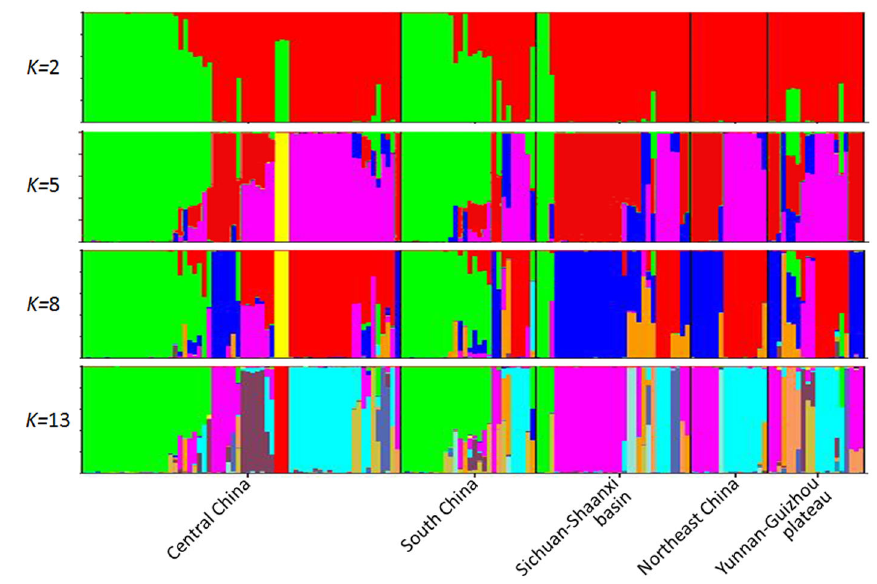
Figure 5. Population structure of U. virens inferred from 125 SNPs of 162 isolates using the program Structure (version 2.3.1), with different K values. An admixture model with correlated allele frequencies was used. Each isolate is represented by a single vertical line broken into K colored segments, with lengths proportional to each of the K inferred clusters.